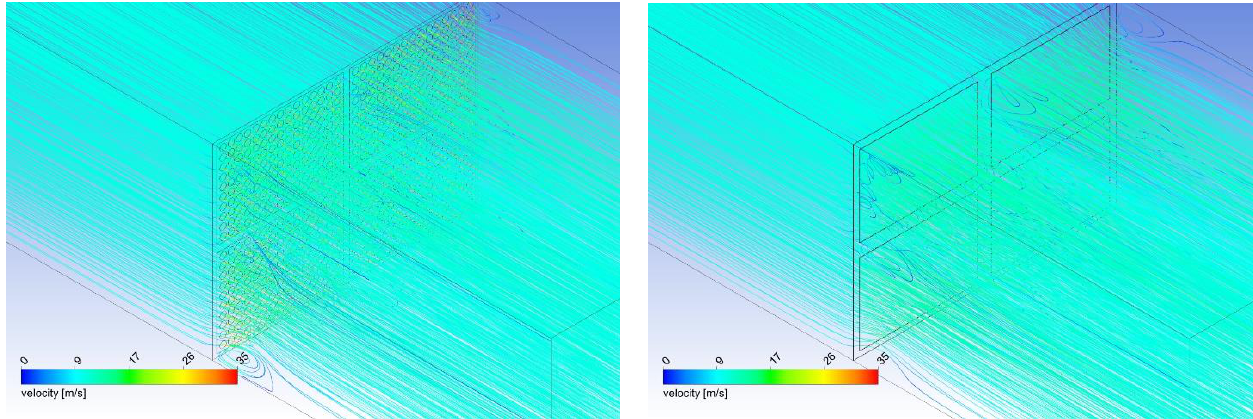
Figure 12. Isometric view on pathlines for four plate panels with open area ratio f = 0.40 ( left ) and corresponding porous